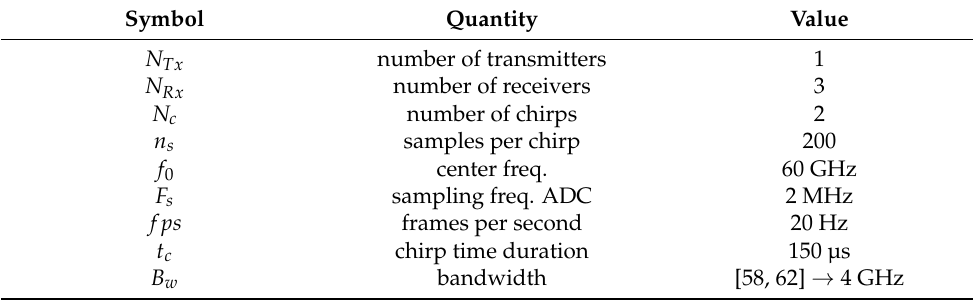
Table 1. BGT60TR13C radar board, parameters configuration for breath sensing. Symbol Quantity